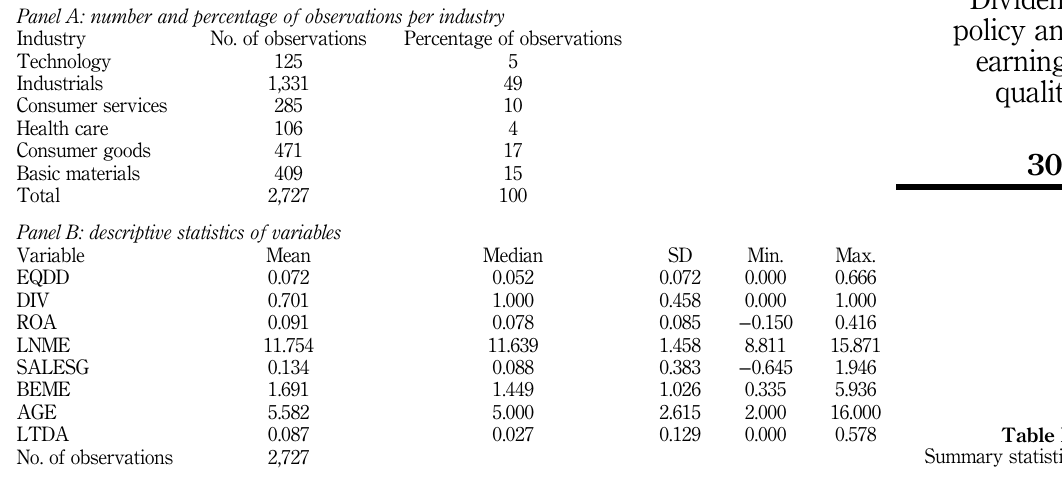
Table II. Summary